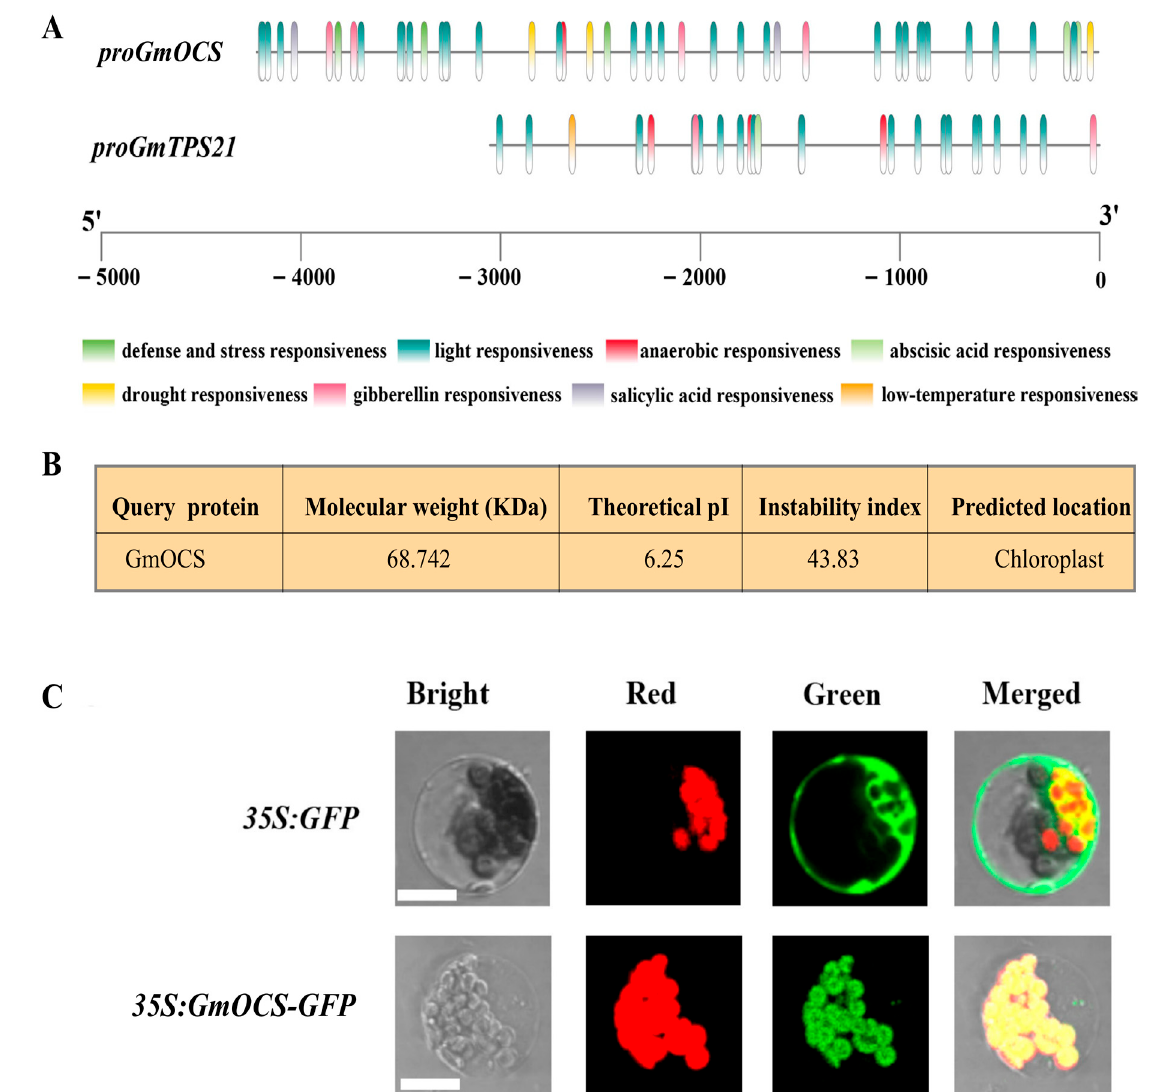
Figure 3. Sequence and subcellular analysis of GmOCS. ( A ) The cis -acting regulatory elements in promoter sequences of GmOCS and GmTPS21 . The 4254 bp and 3052 bp upstream sequences of the initiation codon ATG were selected as promoter sequences of GmOCS and GmTPS21 , respectively, and were analyzed by PlantCARE followed by being visualized with Simple BioSequence Viewer in TBtools [45]. ( B ) Basic sequence information of GmOCS. GmOCS sequence properties were analyzed with the ExPASy Protparam tool and Plant-mPLoc server with default parameters. ( C ) Subcellu- lar localization of GmOCS in Arabidopsis protoplasts. Green, GFP fluorescence; Red, chlorophyll fluorescence; Bright Light, brightfield image; Merged, merged green, red, and bright light images. Scale bar = 25 µm.